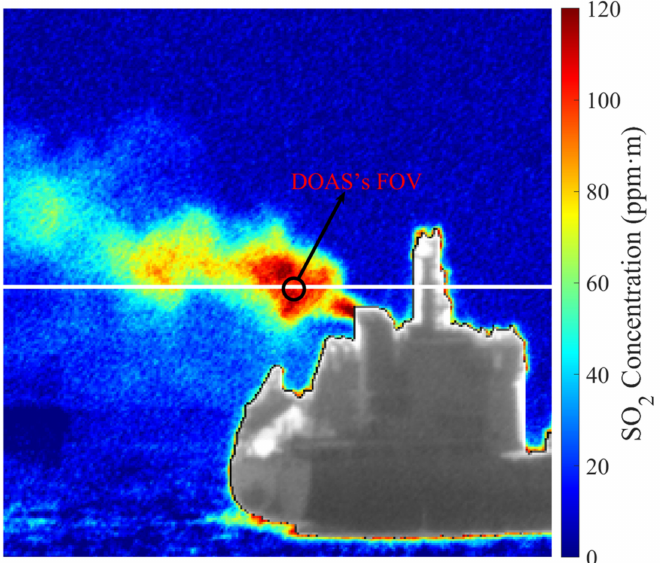
Figure 10. SO 2 image of ship exhaust obtained with a distance of about 3.5 km. The selection principle of row pixels passing through the plume center and FOV of DOAS are consistent with those in Figure 8.